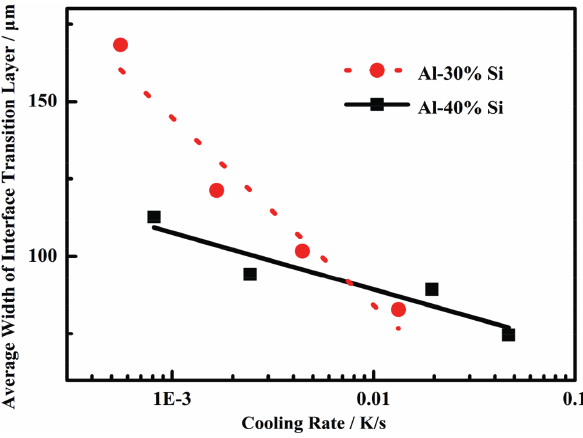
Figure 5: Average width of the interface transition